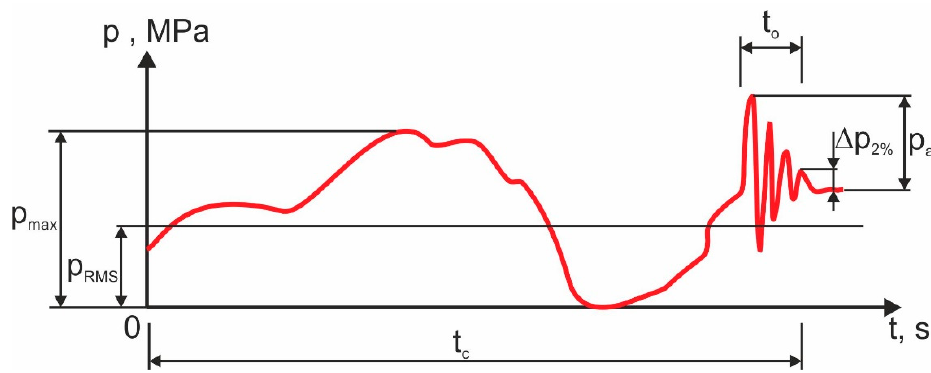
Figure 5. The scheme of indicators to evaluate pressures.